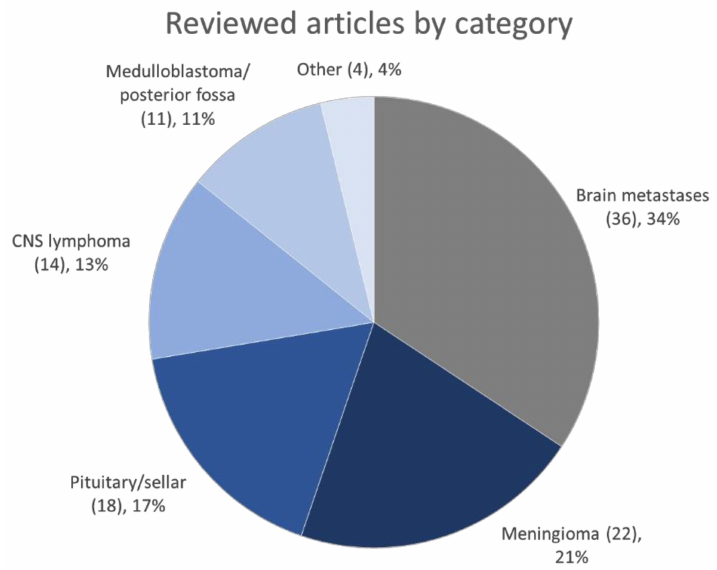
Figure 2. Number of reviewed articles by